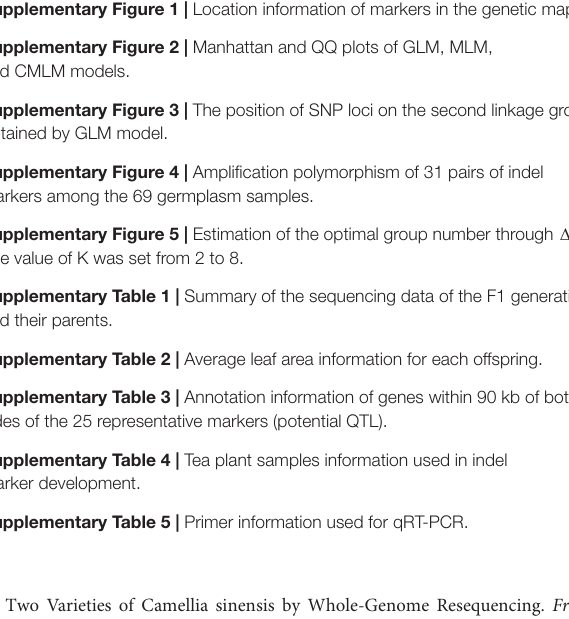
Supplementary Table 4 | Tea plant samples information used in indel marker development. Supplementary Table 5 | Primer information used for